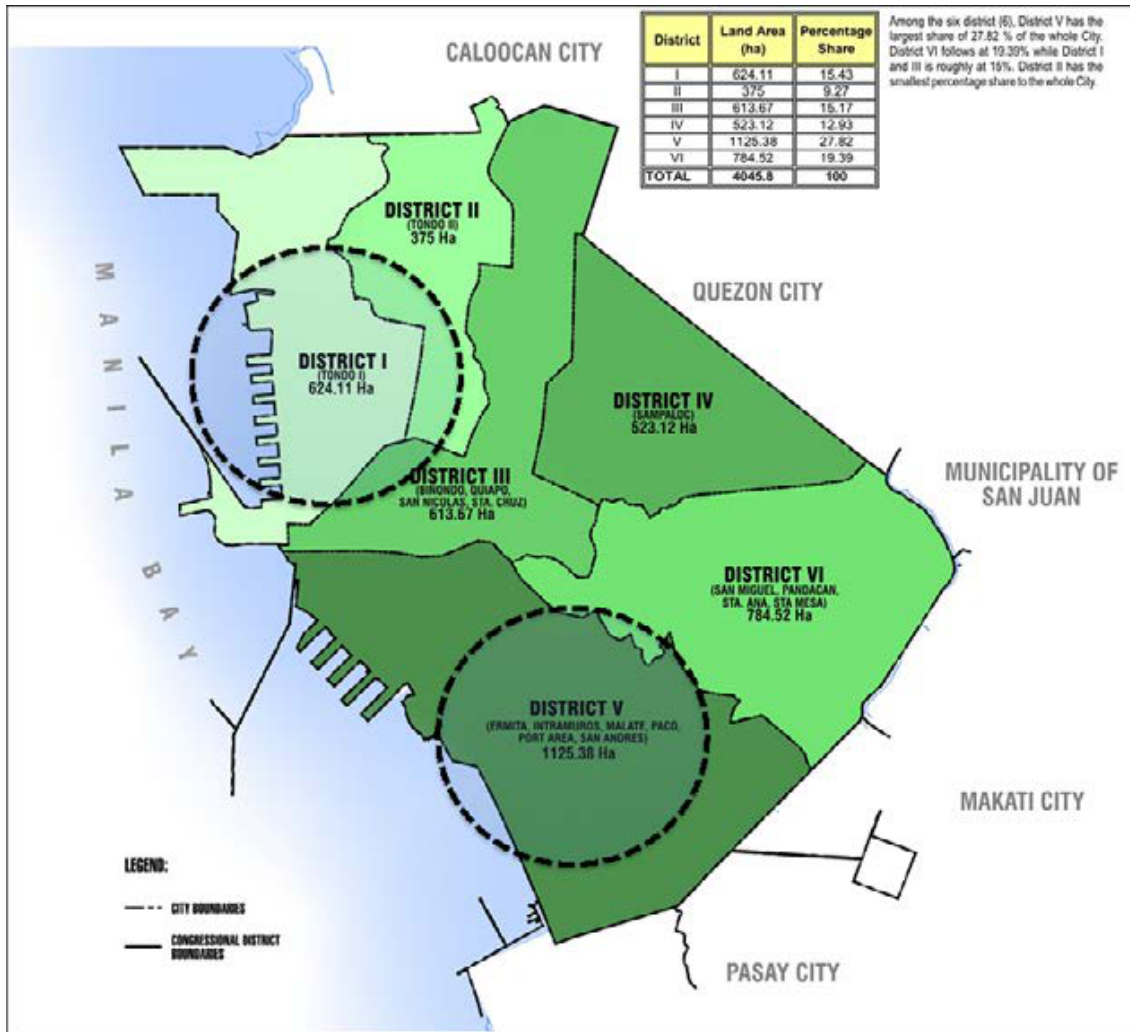
Figure 2. Location map for District 1 and District 5 of ManilaCity, PhilippinesSource: MCLUPZO 2005-2020 ec385abf1236